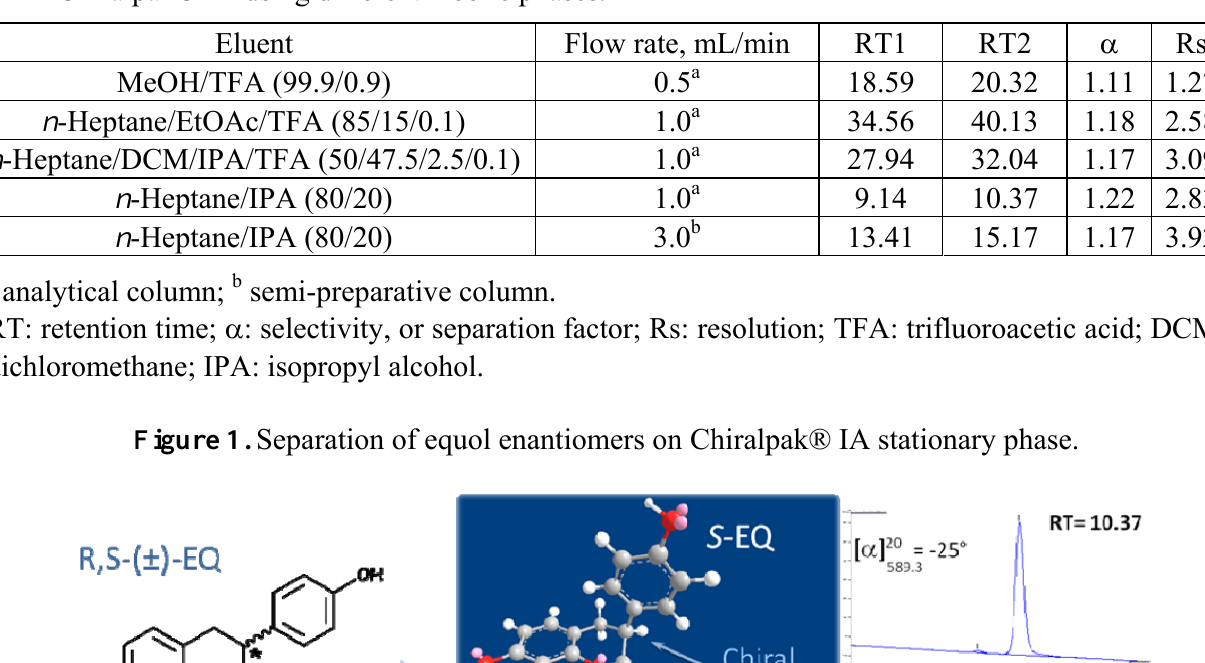
Table 1. Examples of enantiomeric separations of racemic equol on chiral stationary phase Chiralpak® IA using different mobile phases.